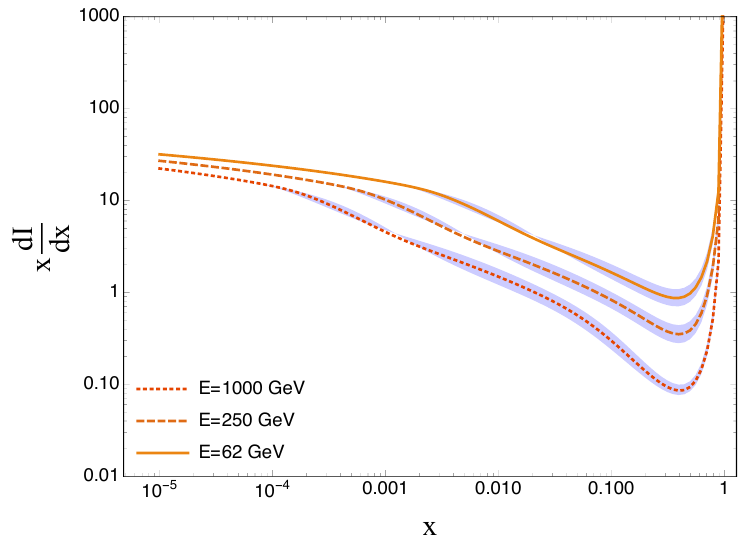
Figure 2 . The matched spectrum up to next-to-leading order, compared to GLV and BDMPS for a jet with energy E = 250 GeV (top) and E = 1000 GeV (bottom). Medium parameters are ^ q = 1 : 5 GeV 2 /fm, (cid:22) = 1 GeV and L = 4 fm.